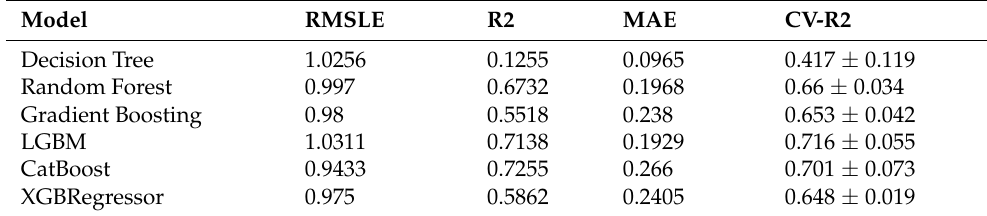
Table 7. Results of severity for the right